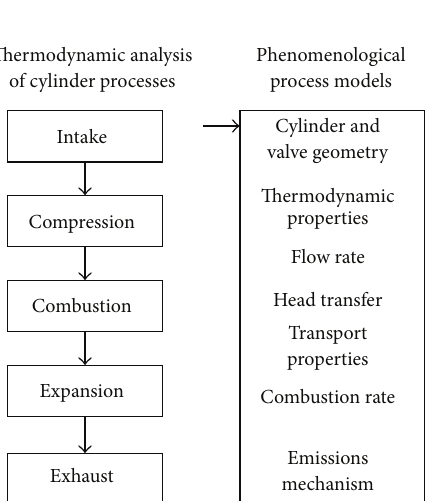
Figure 3: Air and fuel flow in ICE.